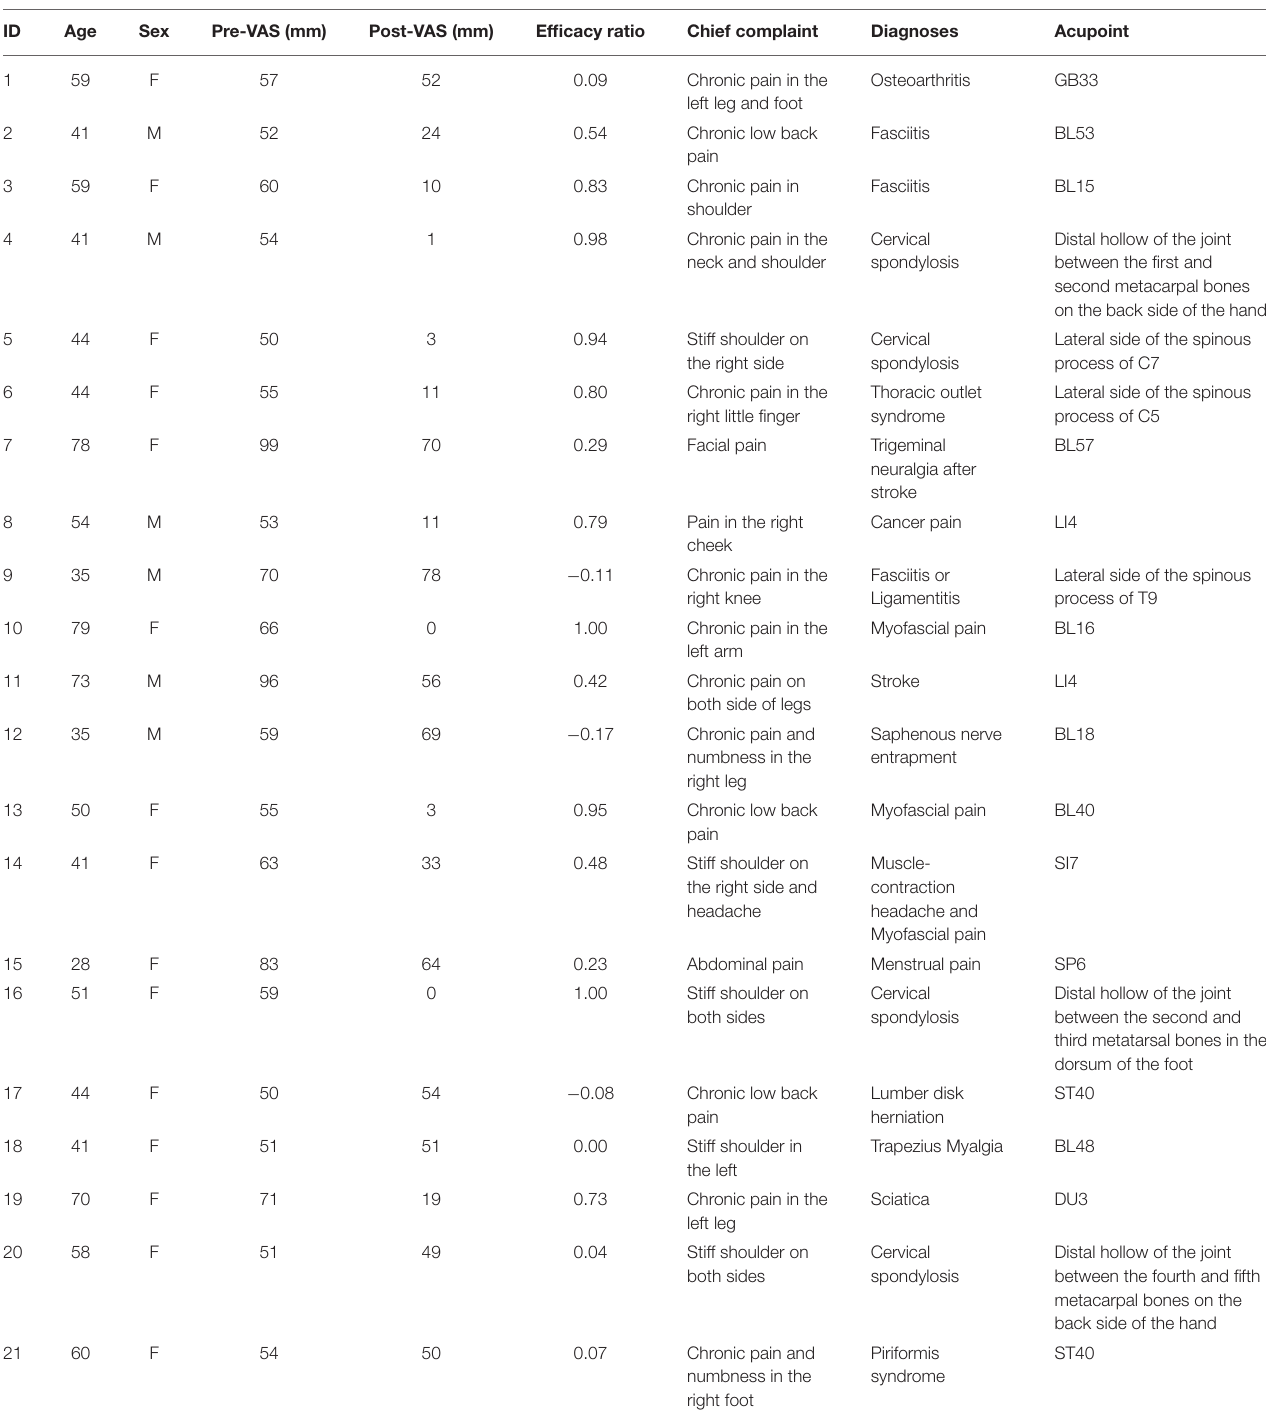
TABLE 1 | Profile of the participants and